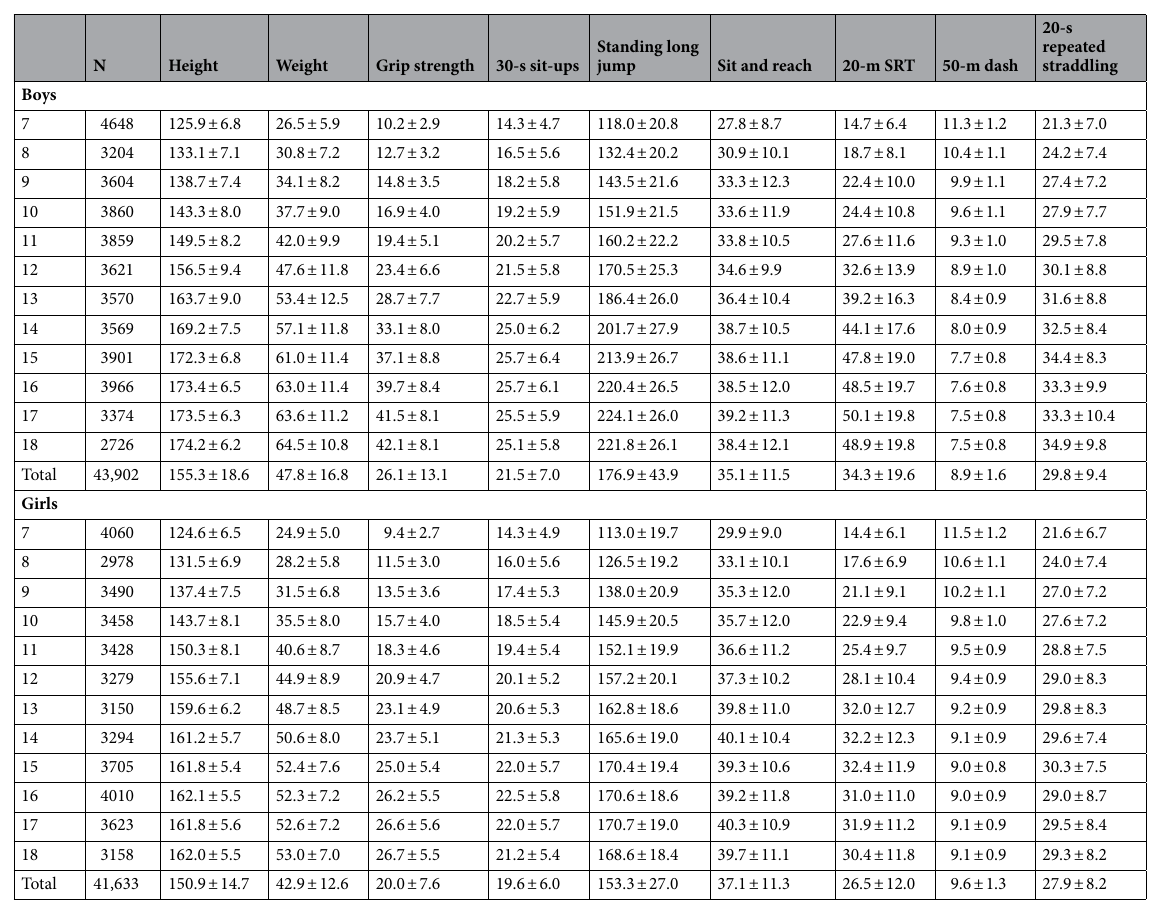
Table 1. The averages and deviation of weight, height, and physical fitness tests by age by